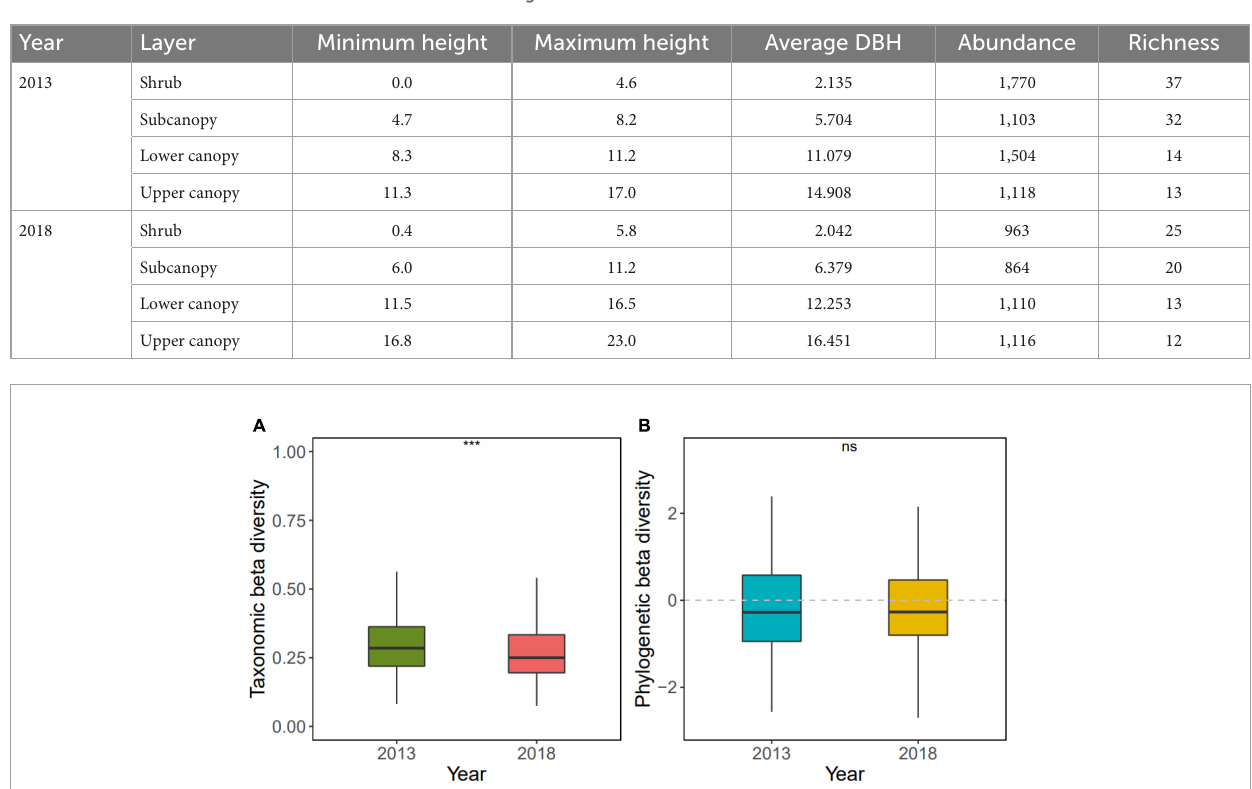
TABLE 1 Basic information on each vertical stratum in the Dongbaishan forest between 2013 and 2018.